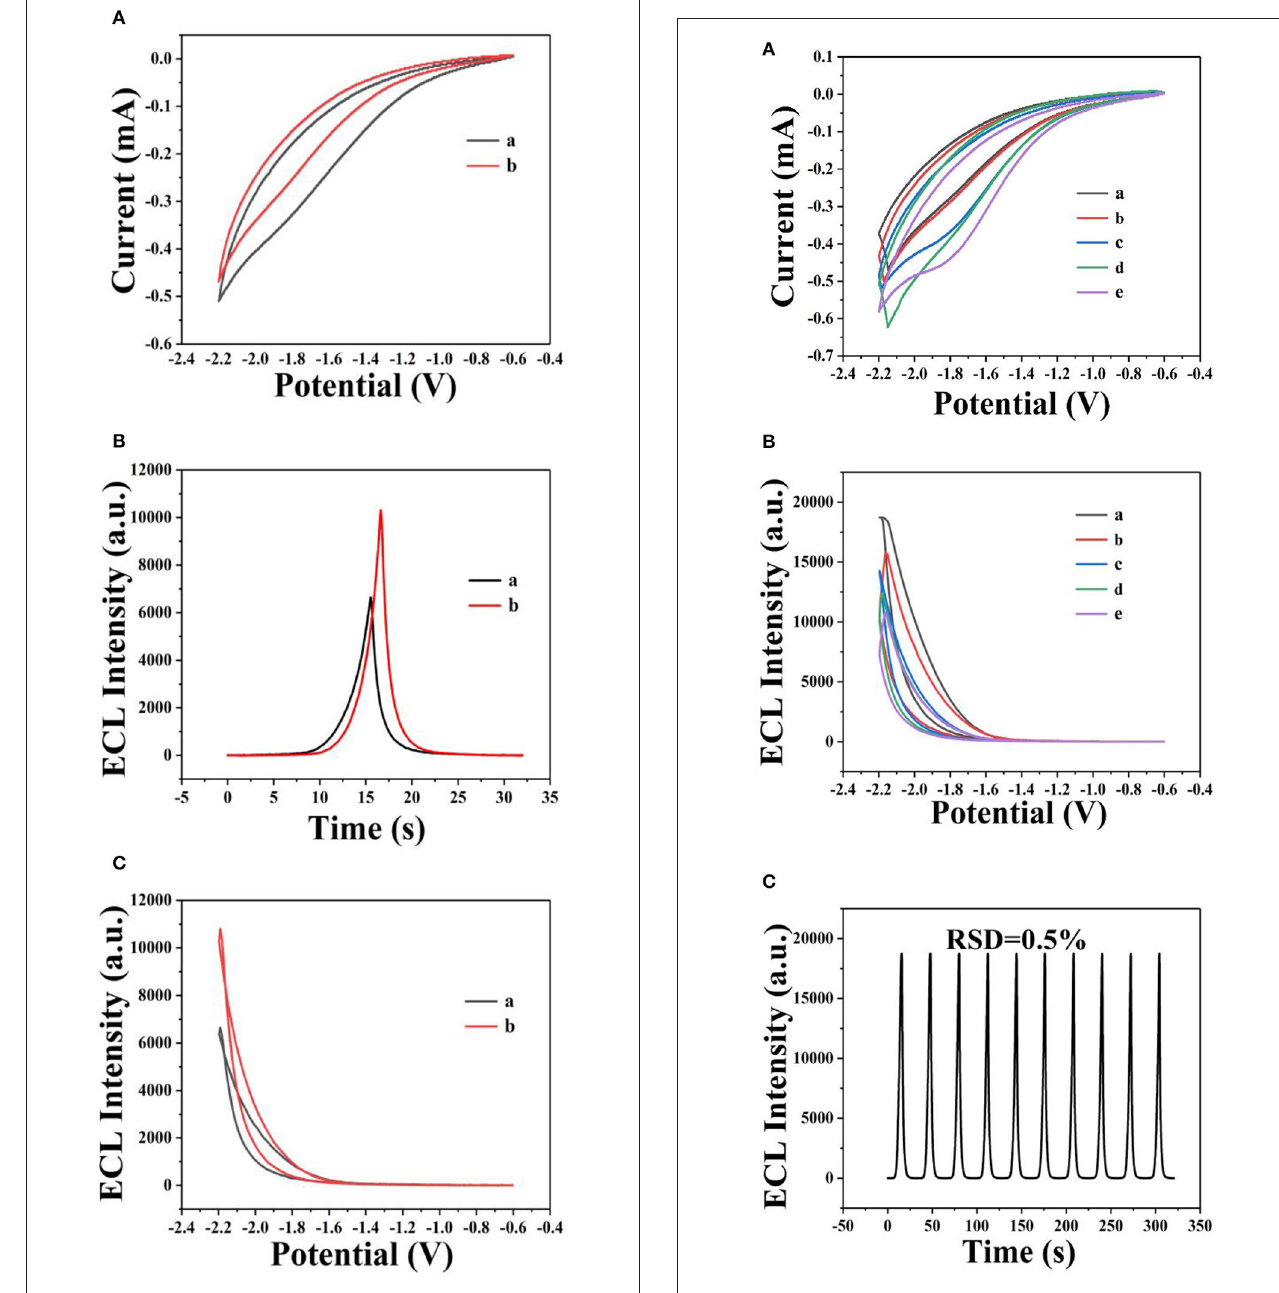
FIGURE 7 | ECL responses from GQDs. Cyclic voltammograms (A) and ECL responses (B) of the GQDs/GCE electrode (a) without sunset yellow and (b) in the presence of 0.025 µ M solution of sunset yellow. (C) ECL response of the GQDs/GCE electrode: (a) without sunset yellow and (b) in the presence of 0.025 µ M solution of sunset yellow. Optimized conditions used for the reactions: GQDs, 0.1 mgmL − 1 ; co-reactant, 0.05M K 2 S 2 O 8 ; supporting electrolyte, 0.08M KCl; PBS (pH 7); scan rate, 0.1 Vs − 1 .